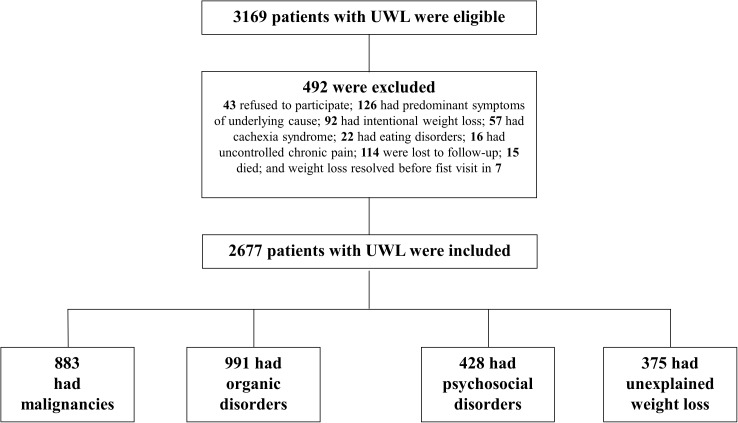
Flowchart of enrollment of patients with unintentional weight loss.